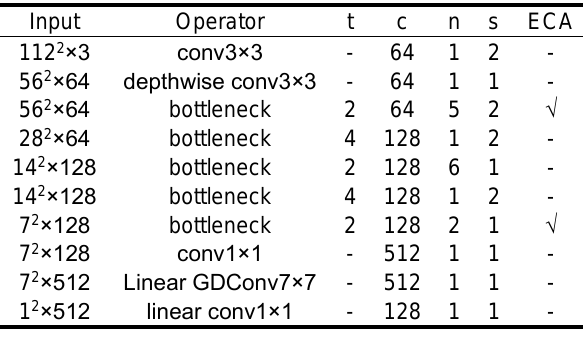
Table 1. MobileFaceNet network structure